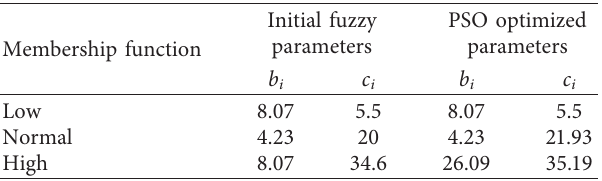
Figure 29: Correlation between forecast load and historical load for total system load. Table 2: Fuzzy-PSO optimized result of temperature for microgrid model.